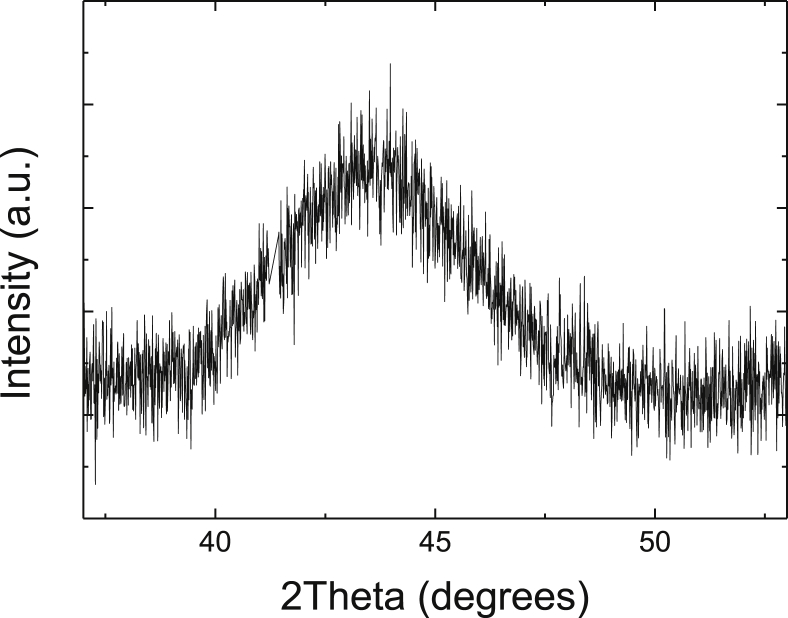
X-ray diffraction pattern of the Fe86Nb14 film.